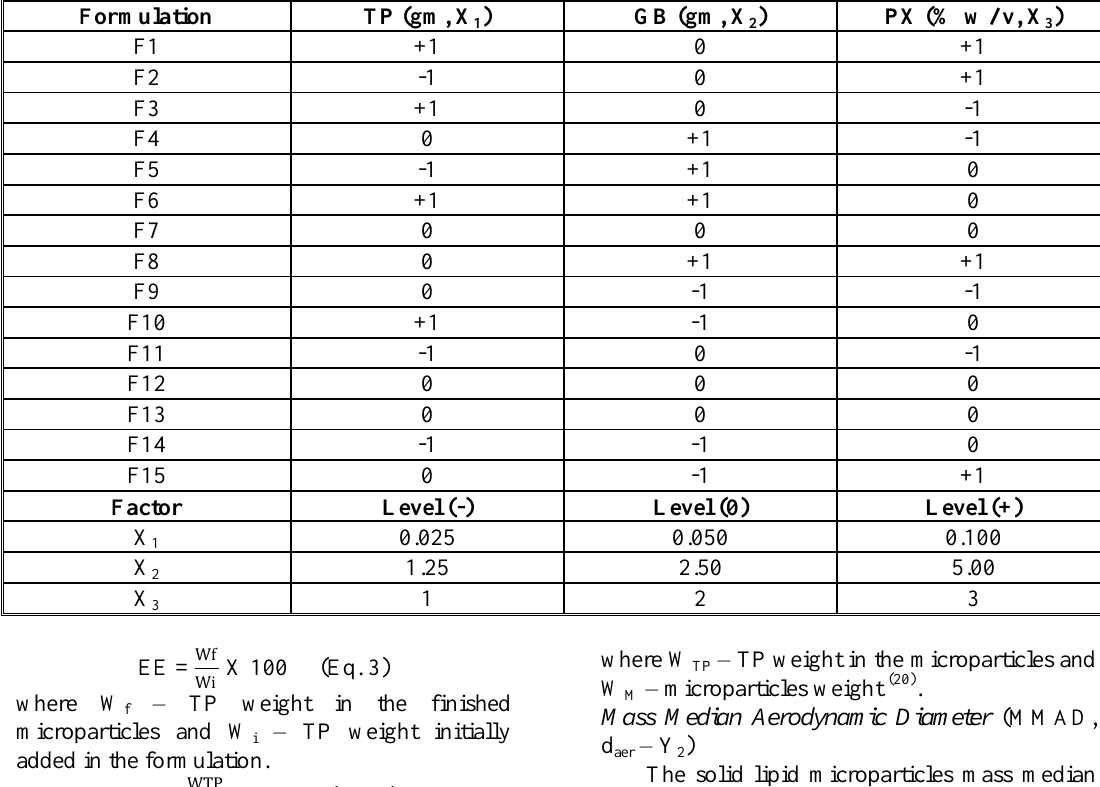
Table 1: Box–behnken experimental design/factorslevels